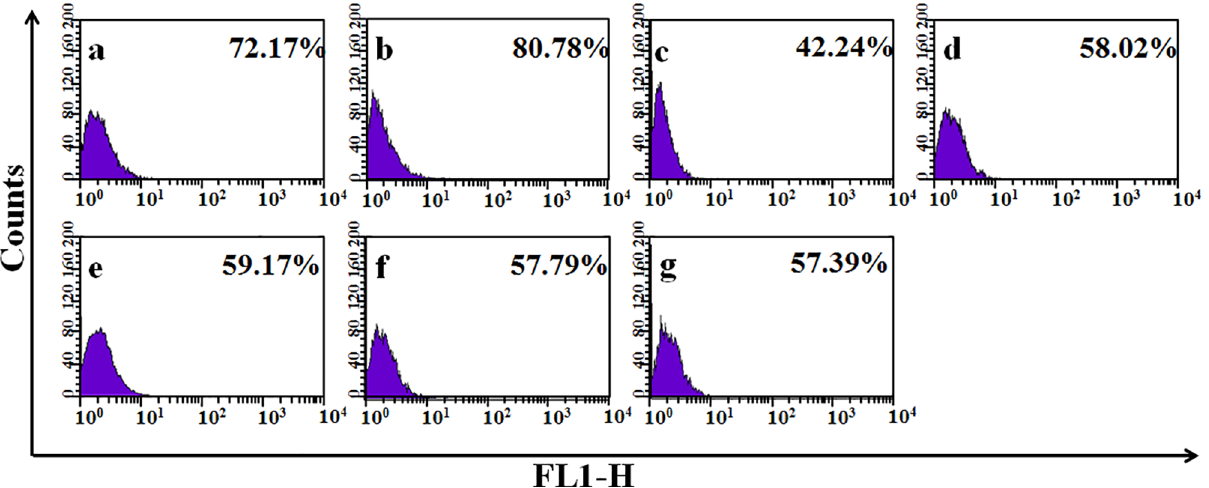
Fig 1. Yields of LRK in neonate epidermis after in utero exposure to iAs and the additives. (A) control, (B) 42.5ppm iAs, (C) 85ppm iAs, (D) 85ppm iAs + selenite (5.6mg mg/kg b wt), (E) 85ppm iAs + curcumin (100mg/kg b wt), (F) 85ppm iAs + selenite + curcumin, (G) 85ppm iAs + ½ dose (selenite + curcumin); Note: exhibit is a FACS generated sketch of cell counts vs. amounts of retained BrdU label displaying unique dispersion patterns of LRK counts. It was visible in framework of the relative fluorescence value outlined on y- axis and the keratinocytes count showing the respective FL1-H counts of fluorescent BrdU-LRKs charted on x-axis. Cells with lowest concentration of BrdU were found to be large in counts, and cells with highest concentration of the fluorescent label were found to be less in counts. The latter group of cells represented the stem cell population in LRK isolates [16, 57]. LRKs were a heterogeneous population of cells as these were isolated from a cluster of neonates born to a group of mother mice.